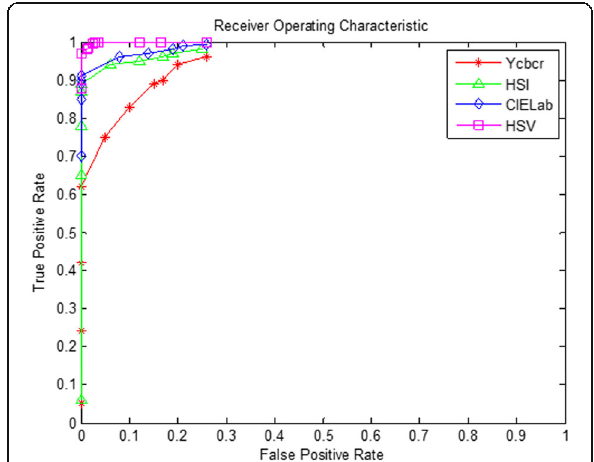
Fig. 13 Receiver operating characteristic for color